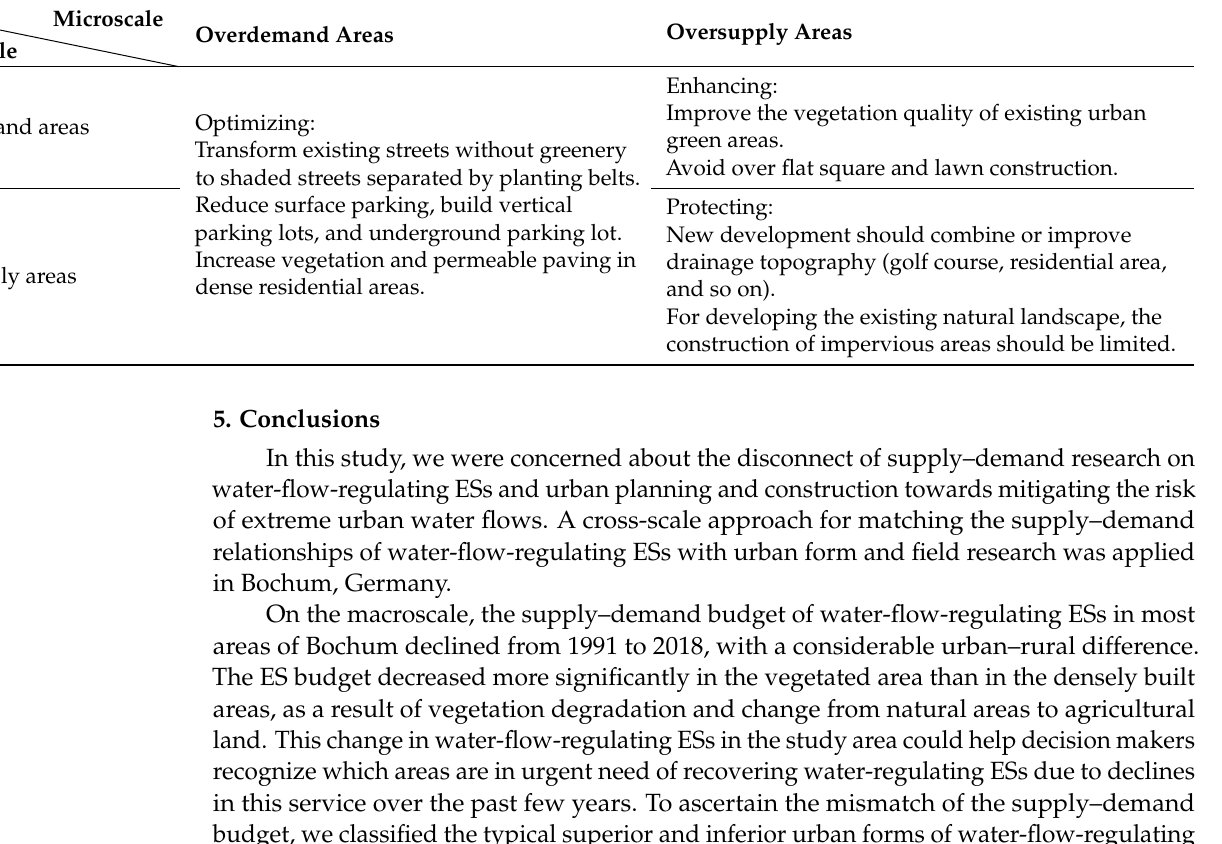
Table 4. Suggestions for future development towards water-flow-regulating ESs in the study area. Microscale Macroscale